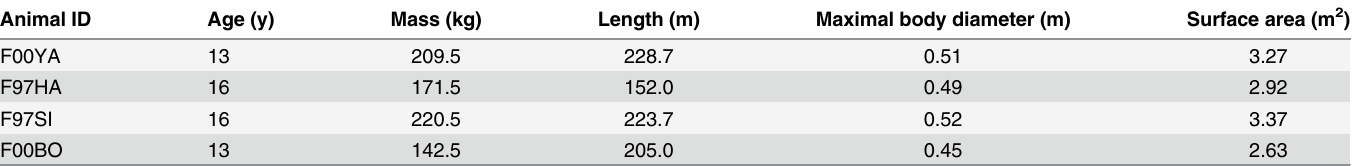
Table 1. Animal ID, age, mass, length and surface area of 4 adult female Steller sea lions that participated in the study. Surface areas estimated by fitting a power curve to published data [20] for similarly-sized animals and extrapolated or interpolated based on their measured body